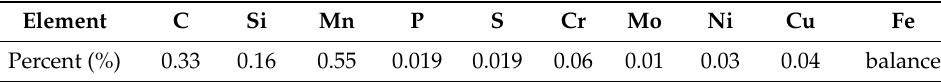
Table 1. The chemical composition of the carbon steel sample was determined by optical emission spectrum GDS 850 A, LECO.